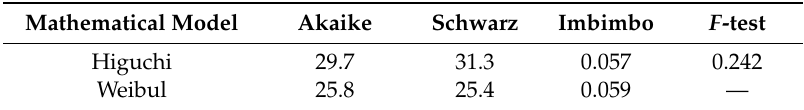
Table 3. Comparison of different mathematical models for evaluating the release kinetic of fluorescein from lyotropic liquid